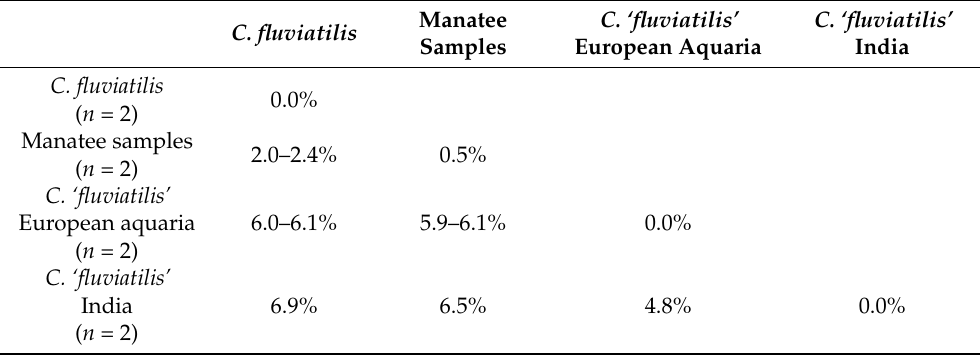
Table 2. Pairwise rbc L sequence divergences between Caloglossa fluviatilis ; Manatee Caloglossa samples “E” and “H.2”, C. ‘fluviatilis’ from European aquaria, and C. ‘fluviatilis’ from